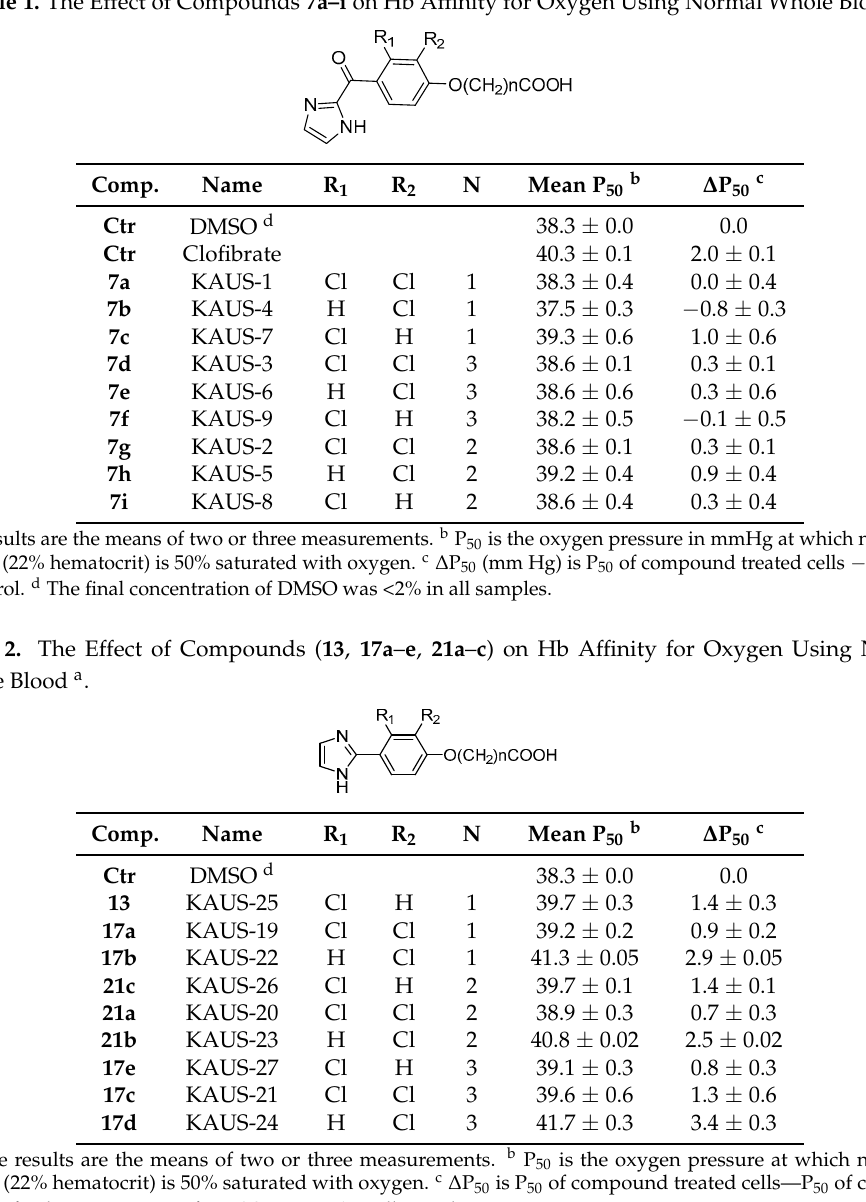
Table 1. The Effect of Compounds 7a–i on Hb Affinity for Oxygen Using Normal Whole Blood a .